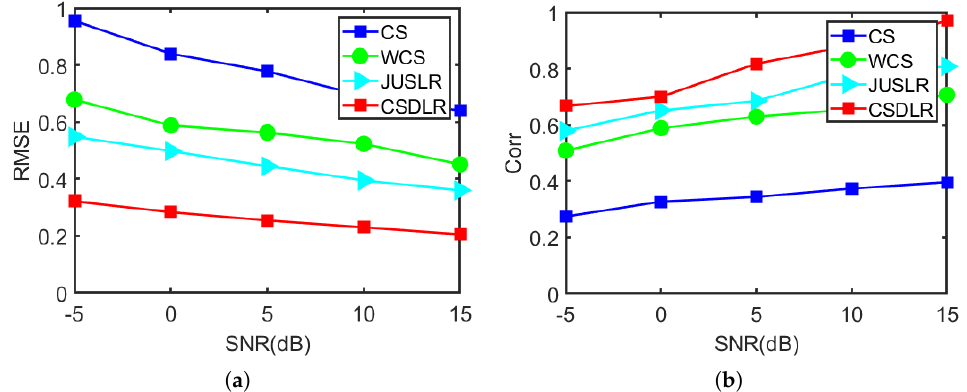
Figure 9. Performance comparison of different imaging methods in ship surface target experiment.